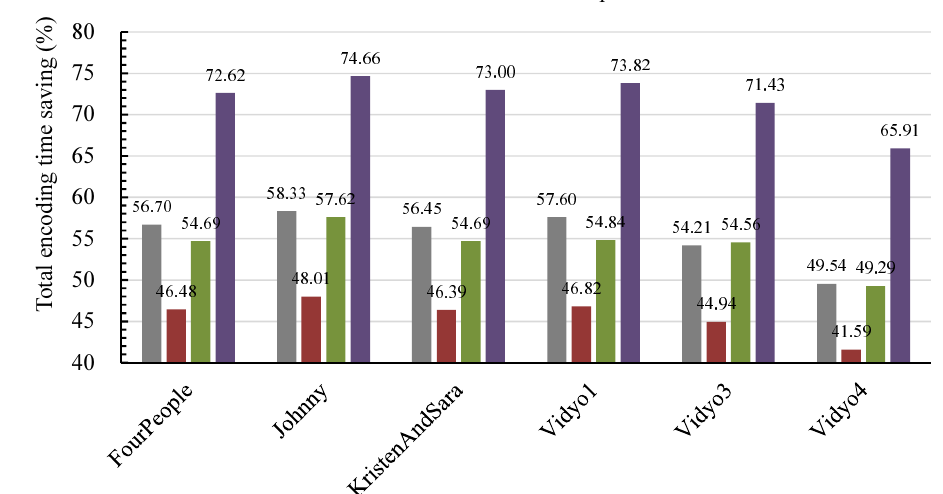
Figure 6. Comparison of the total encoding time